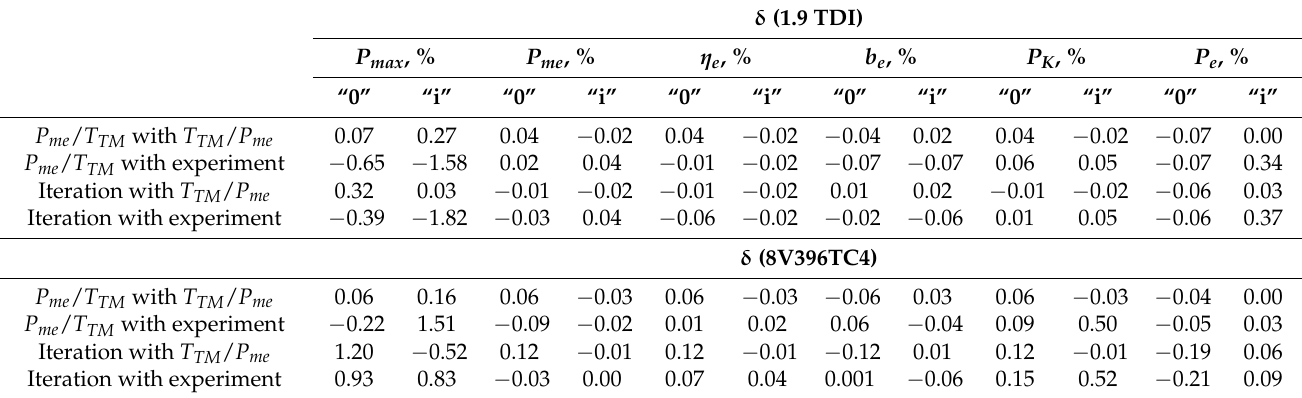
Table 5. Data of relative errors of main work parameters of 1.9 TDI and 8V396TC4